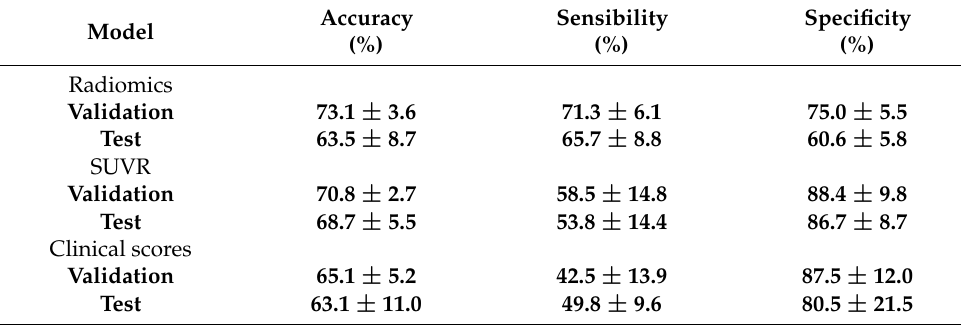
Table 3. The classification results for MCI vs. NC subjects.